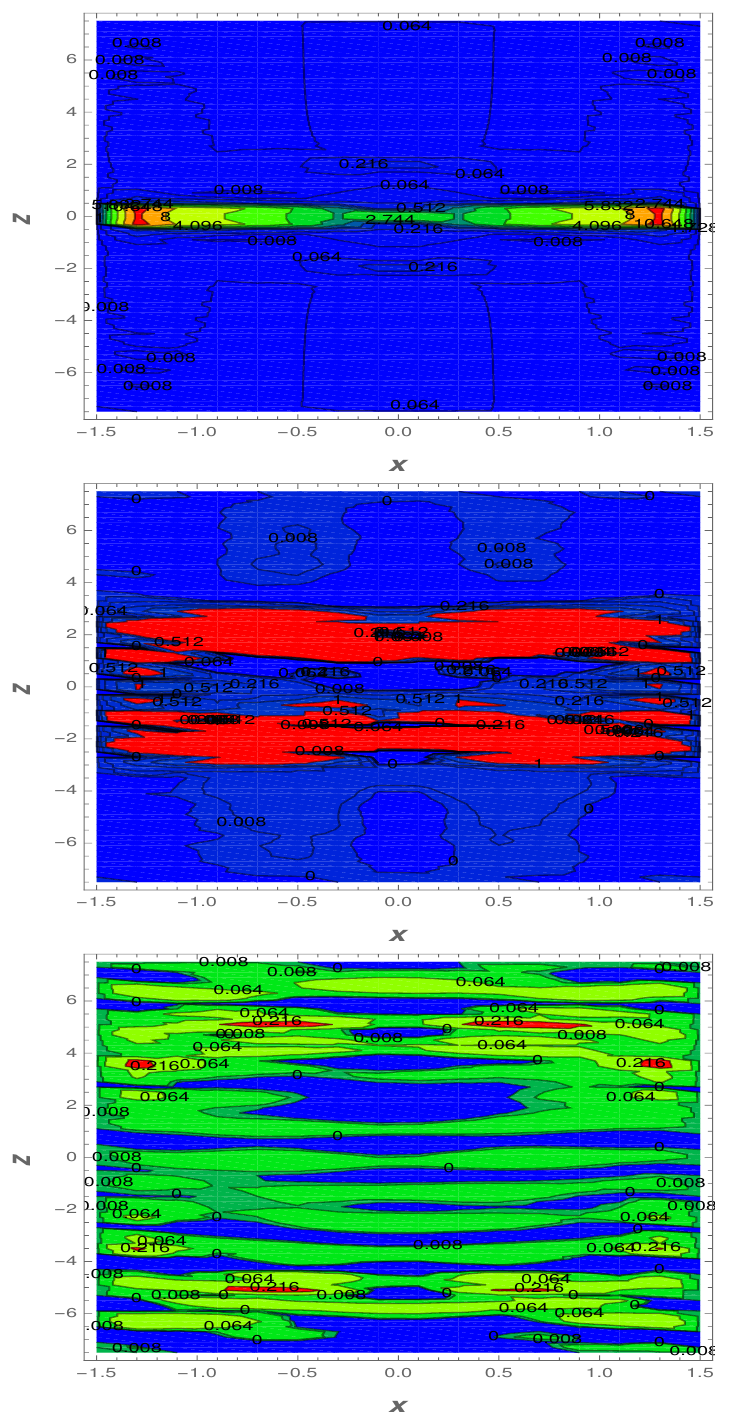
Figure 3 . The square root of the three components of the constraint added in quadrature at times t = 0 : 2 (top), t = 3 (middle) and t = 15 (bottom) for two monopoles starting at z = (cid:6) 2. An initial violation of the constraint at z = 0 spreads into the volume and di(cid:11)uses as the system relaxes to a solution. The (cid:12)nely spaced grid is plotted.